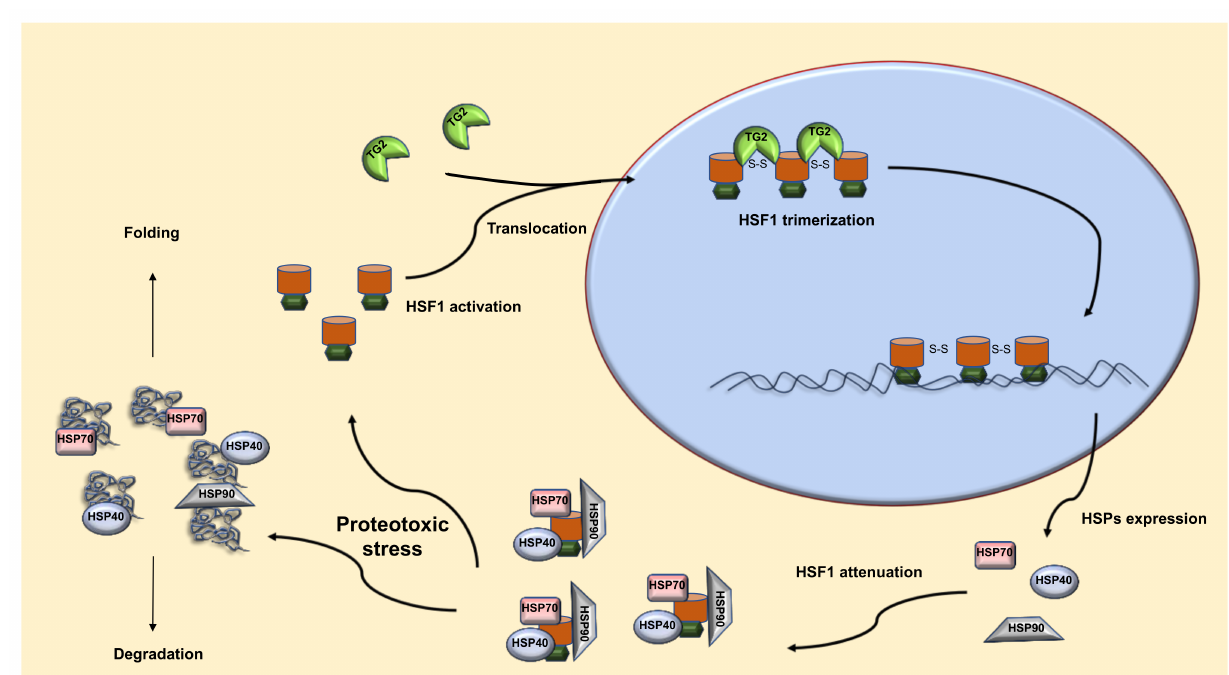
Figure 1. The Heat Shock Response. A proteotoxic stress leads to an increase in misfolded proteins that are bound by HSPs to mediate proteins folding or their degradation. Activated HSF1 moves into the nucleus where it is trimerized by TG2. HSF1 trimers bind HSE sequences stimulating HSPs expression in order to reduce the misfolded peptides accumulation. The new synthetized chaperones interact with monomeric HSF1 to attenuate the heat shock